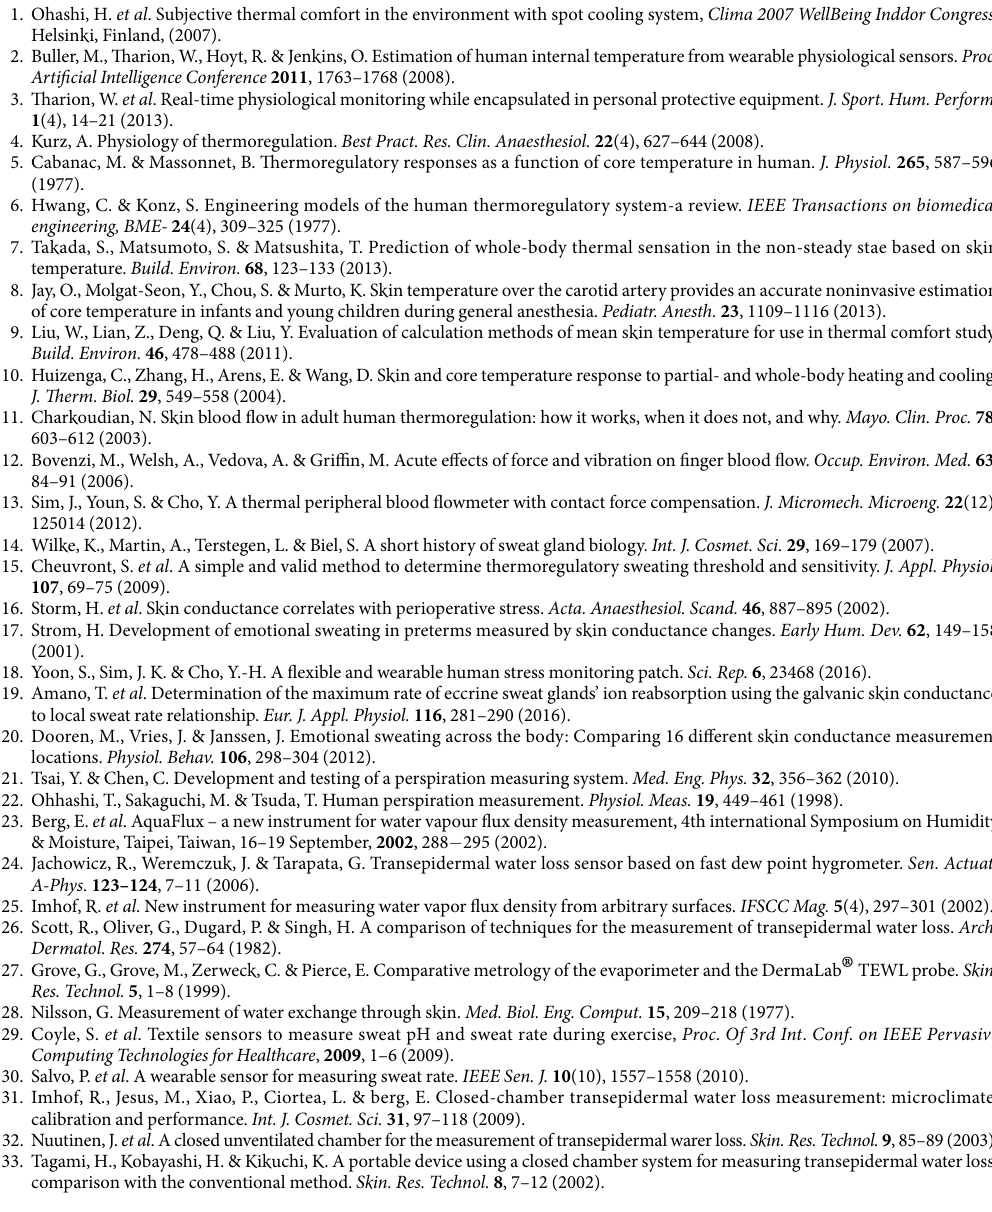
vides quantitative sweat rate with a unit of g/m 2 h, thus considered as reference methods to sweat rate detection. and the semipermeable membrane thickness. Then, the water evaporation (sweat rate) is calculated by the three measured data: